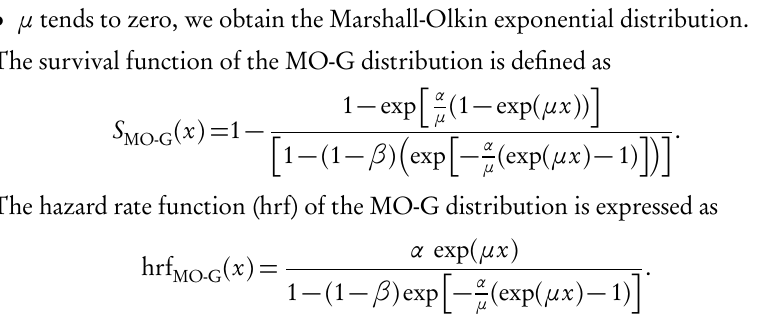
Figure 1 – The density plot for MO-G